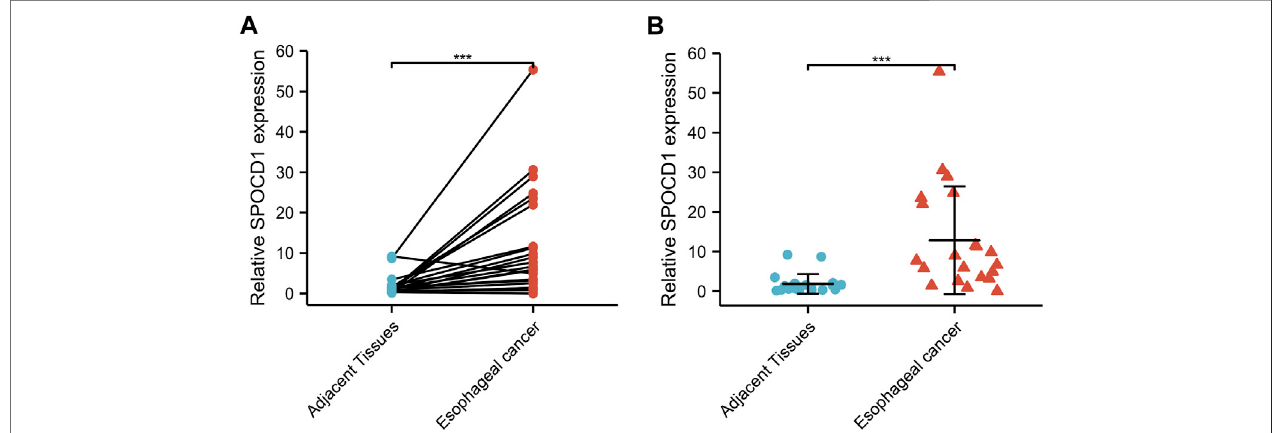
FIGURE 11 | The SPOCD1 expression in ESCC (n = 21), and adjacent normal tissues (n = 21) was evaluated by qRT-PCR. (A) The results were analyzed using paired sample t test; (B) The results were analyzed using Wilcoxon rank sum test. Results expressed as mean ± standard deviation (SD). *** p < 0.001, *** p <